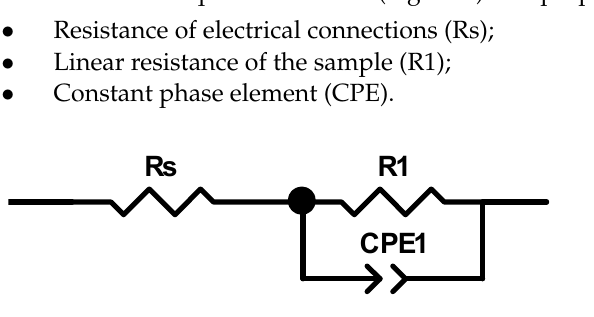
Figure 8. Equivalent Circuit Model.